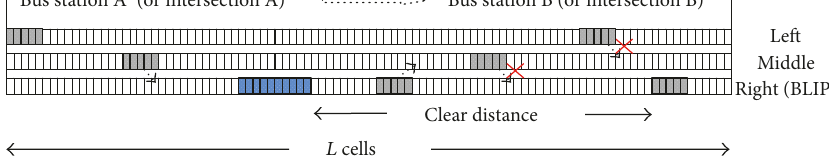
Figure 1: Diagram of three-lane traffic using V2V-based